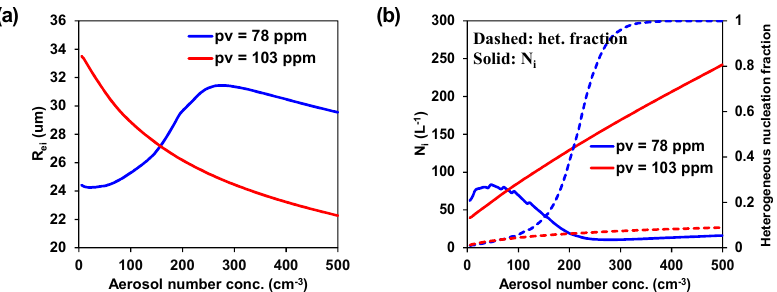
Figure 5. Simulated changes in (a) R ei and (b) ice crystal number concentration ( N i ) and the fraction of ice crystal number produced by heterogeneous nucleation (het.) as a function of the total aerosol number concentration. Simulations are conducted for two initial water vapor mass mixing ratios (pv), an indicator of available water amount for ice formation. The ratios of externally mixed dust (deposition INP), coated dust (immersion INP), and sulfate (not INP) are prescribed values of 0 . 75 : 0 . 25 : 10000 in all